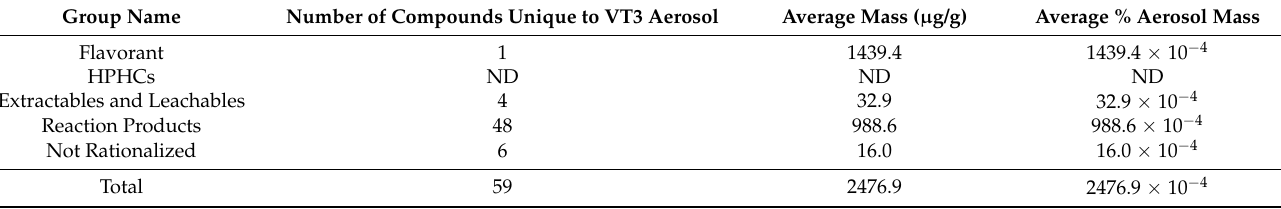
Table 8. Compounds Exclusive to JUUL VT3 Aerosol Compared to Cigarette Smoke.